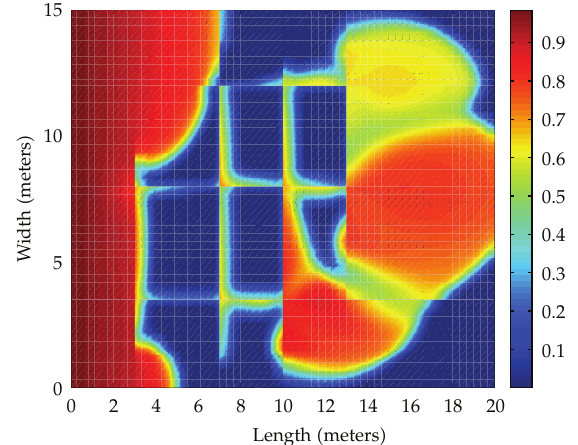
Figure 10: Water saturation profile at 0.5 PVI by the proposed method: Example